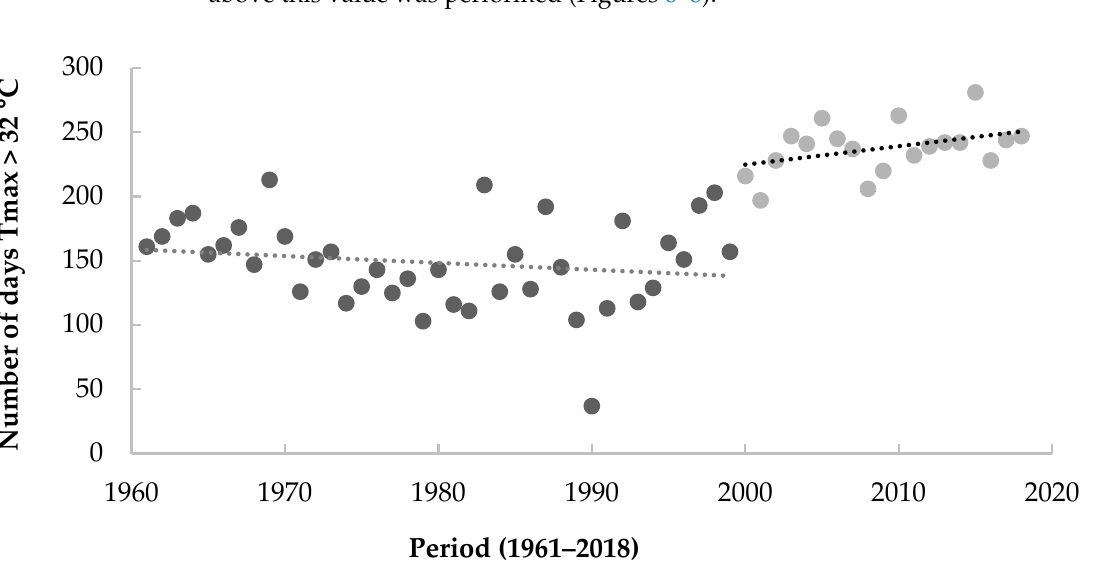
When analyzing the data from the historical period, the average maximum daily temperature found for the period from 1961 to 2018 was 31.8 ◦ C. For this study, the mean was rounded to 32 ◦ C and then the analysis of the number of annual days of temperature above this value was performed (Figures 6–8).